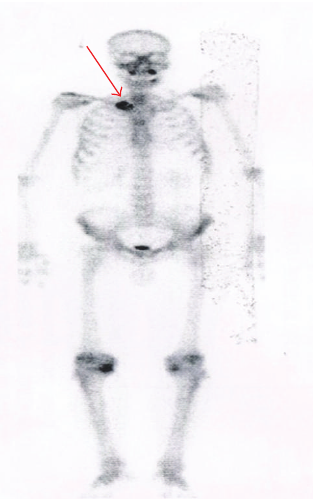
Figure 3: Bone scintigraphy image showing increasing intensity of tracer uptake localized in the sternoclavicular joint.